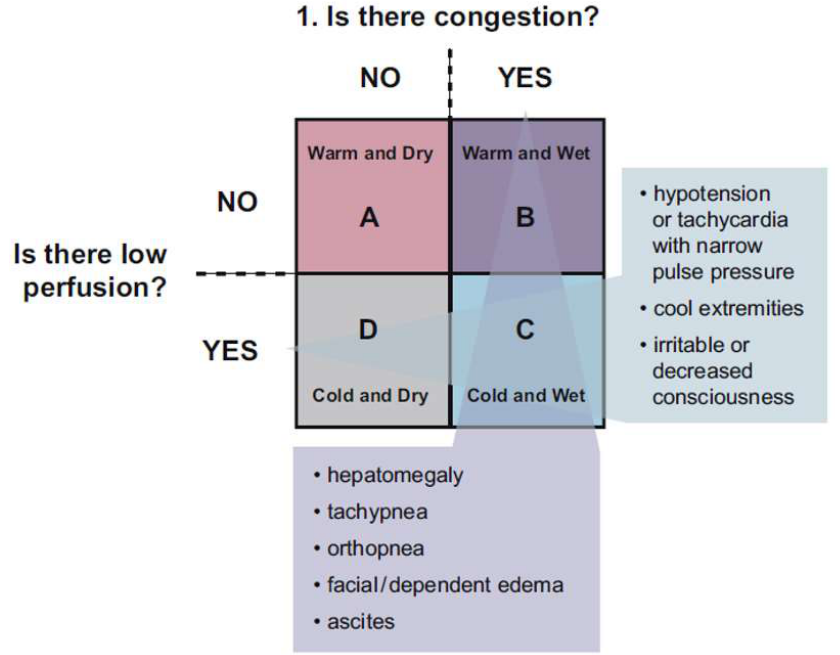
Figure 3. Perfusion and congestion model: patterns of presentation in heart failure in children [22]. (Presented with permission from the Publisher, Elsevier, originally published in Canadian Journal of Cardiology 2013; 29:1535-1552) (License Number 4335401450214).